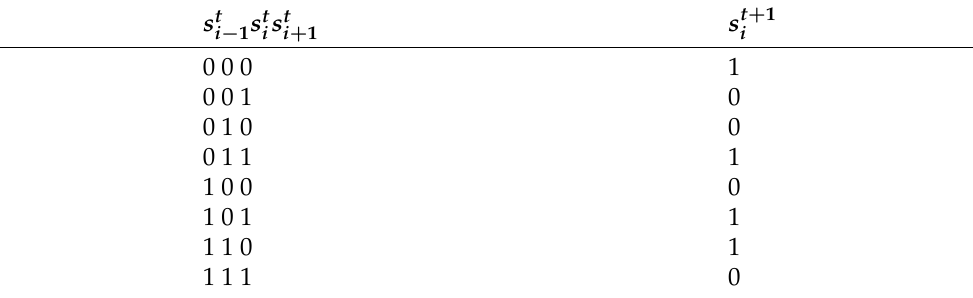
Table 1. Truth table of ECA (No.